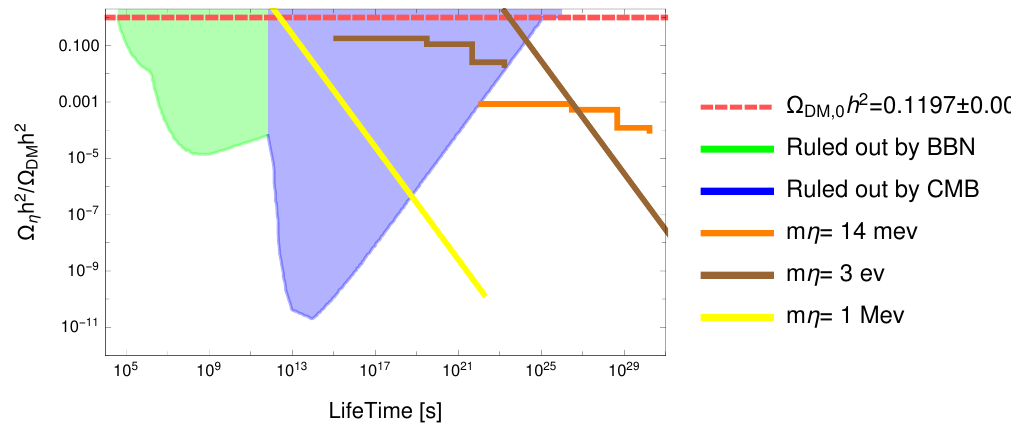
Figure 6 . The abundance vs. lifetime of (cid:17) for di(cid:11)erent m (cid:17) . The green and blue areas show the excluded regions from BBN and CMB observations [13],